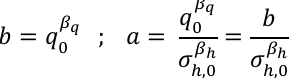
is related to the 0 is related to the maximum value h.0